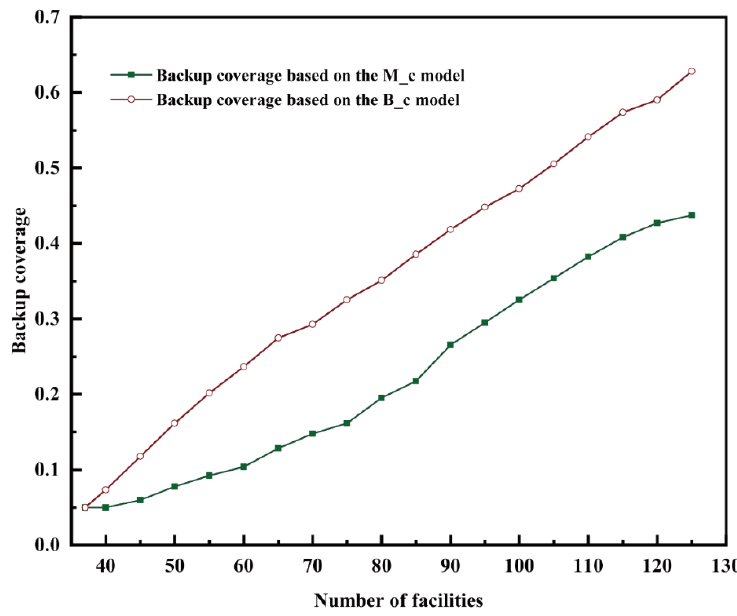
Figure 9. Comparison of backup coverage in the two models.